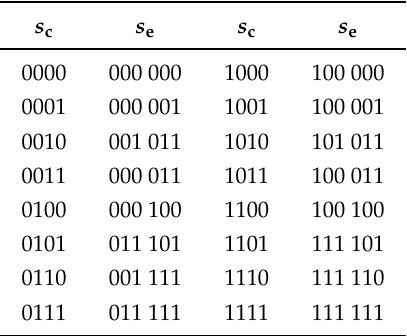
Table 2. Expansion mapping